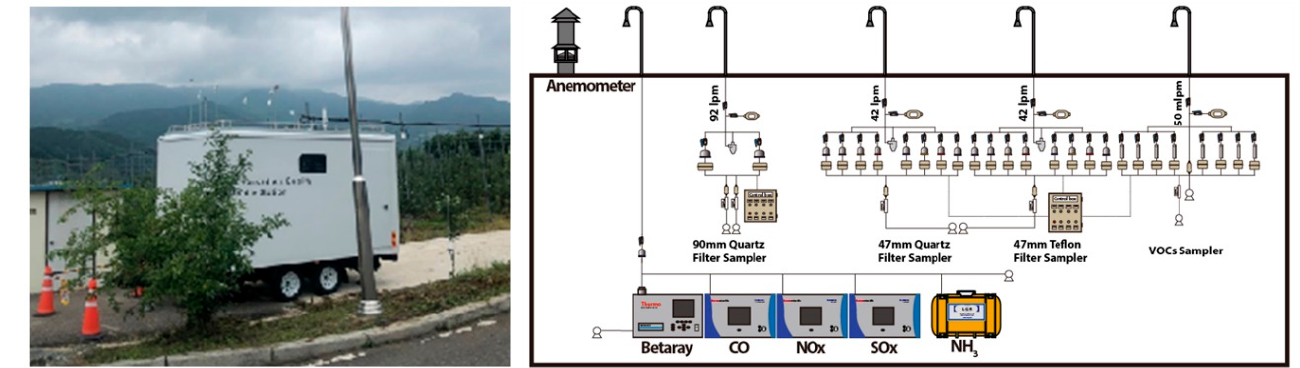
Figure 2. Picture of air monitoring trailer and schematic of the air monitoring instruments and samplers in the air monitoring trailer.